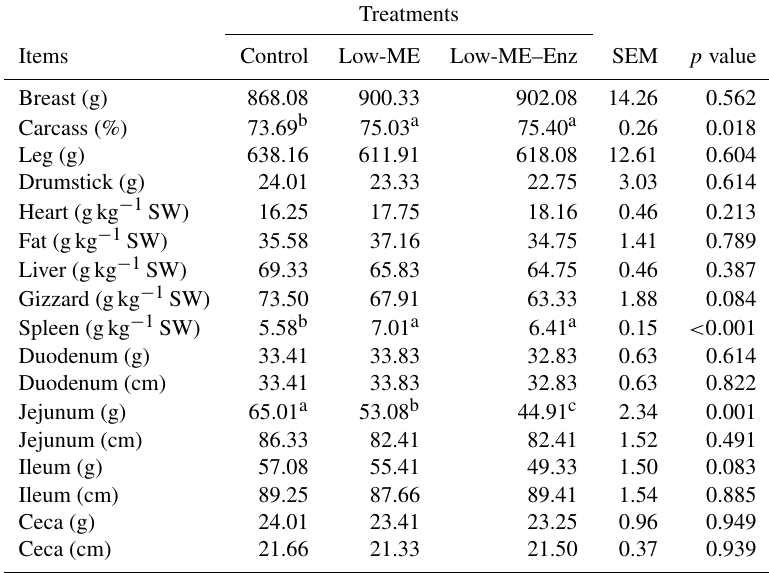
Table 3. Effects of treatments on carcass yield and proportions of various carcass parts and organs ( n = 6). Treatments Items Control Low-ME